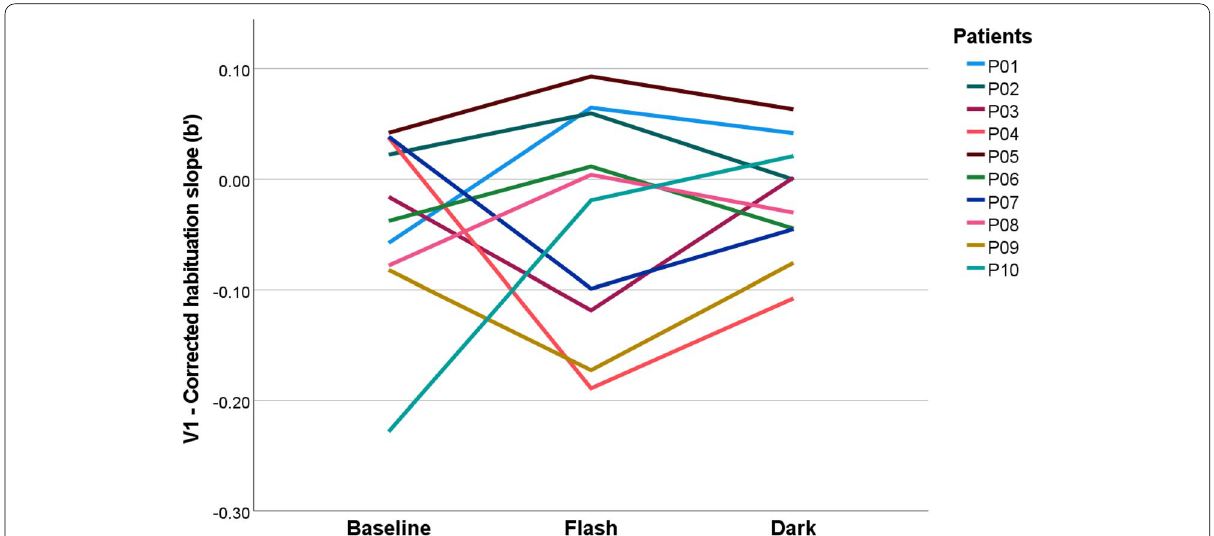
Fig. 6 Corrected habituation slope ( b’ ) for the primary visual cortex (V1) in all migraine patients individually. In the Flash condition, an increased habituation slope was found in 6 patients (P01, P02, P05, P06, P08, P10) and a decrease in 4 patients (P03, P04, P07, P09) compared to the baseline. In the Dark condition, 6 patients showed an increased b’ (P01, P03, P05, P08, P09, P10) and 4 a declined b’ (P02, P04, P06, P07) relative to the